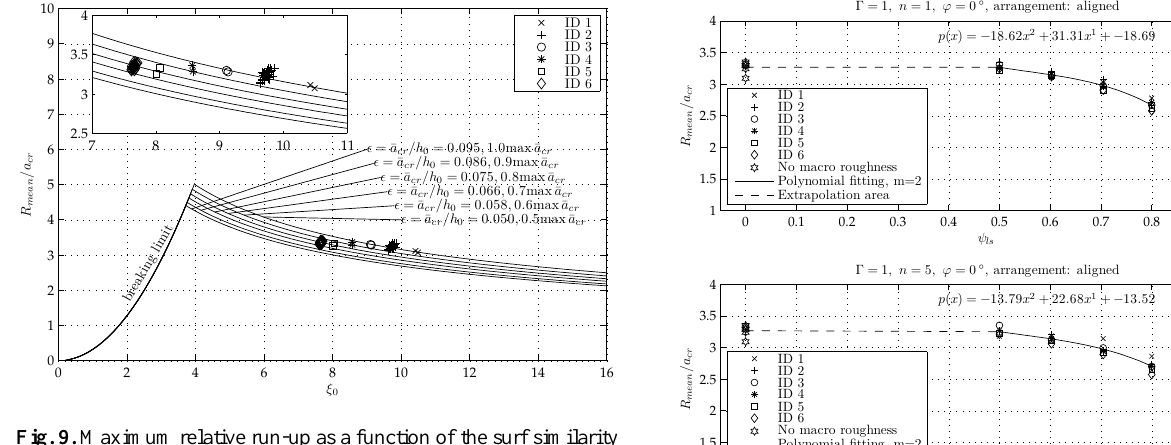
Fig. 9. Maximum relative run-up as a function of the surf similarity parameter ( ξ 0 ) depicted by the markers and according to the wave conditions applied, the theoretical breaking limit given by Eq. 5 and the theoretical run-up functions given by Eq. 3 (Madsen and Schäf- fer, 2010) based on the non-linearity ( (cid:15) ). The inset zooms to the experimental data.